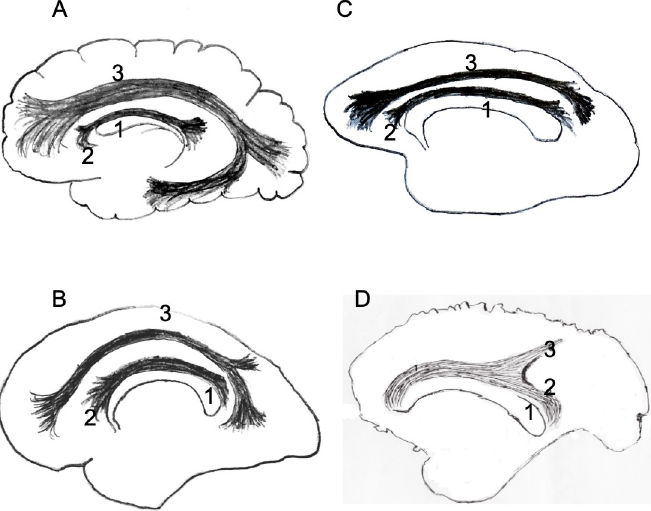
Fig 5. Schematic drawings of the brains of [A] human, [B] chimpanzee [representing the apes], [C] macaque and [D] Sapajus , indicating the [1] corpus callosum, [2] cingulate fascicle and [3] longitudinal fascicle.